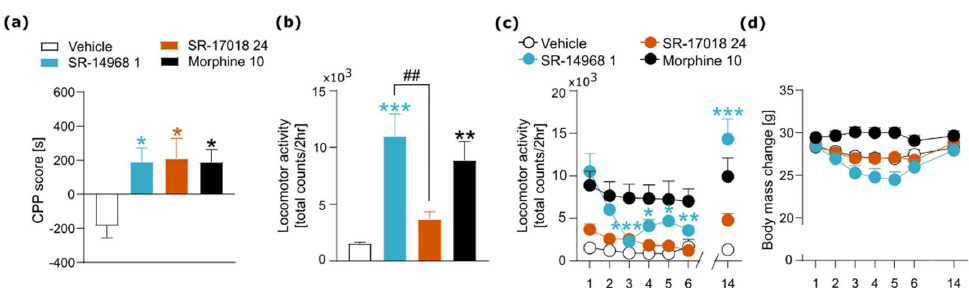
Figure 4. Influence of SR compounds on reward-associated behavior and locomotor activity. ( a ) SR-14968 (1 mg/kg, i.p.), SR-17018 (24 mg/kg, i.p.) and morphine (10 mg/kg, i.p.) induced a preference towards the drug-associated compartment in a CPP test. ( b ) An acute treatment with SR-14968 and morphine, but not with SR-17018, caused an enhancement of locomotor activity. ( c ) Repeated administration of SR-14968 led to the tolerance of locomotor effects, whereas SR-17018- and morphine-treated mice did not present significant changes over a 6-day period of chronic drug treatment. Administration of SR-14968 after the incubation period of 8 days resulted in high expression of locomotor activity on day 14. ( d ) Body mass changes across the experiment. Data are presented as the mean ± SEM. Significant effects resulting from post hoc analysis are marked on the graphs: in ( a , b ) effects of treatments compared to a vehicle group are marked with * and differences between SR-agonist-treated groups are marked with #, in ( c , d ) with * are marked within-group effects compared to the first day of the experiment and expression of locomotor activity (within-group differences between the activity on day 6 and 14). * p < 0.05, **/## p < 0.01, *** p < 0.001. Numbers of animals: ( a ) vehicle n = 9; morphine n = 8; SR-1468 and SR-17018 n = 10, ( b ) all groups n = 10, ( c , d ) vehicle n = 10; morphine n = 10; SR-1468 n = 9; SR-17018 n = 10.